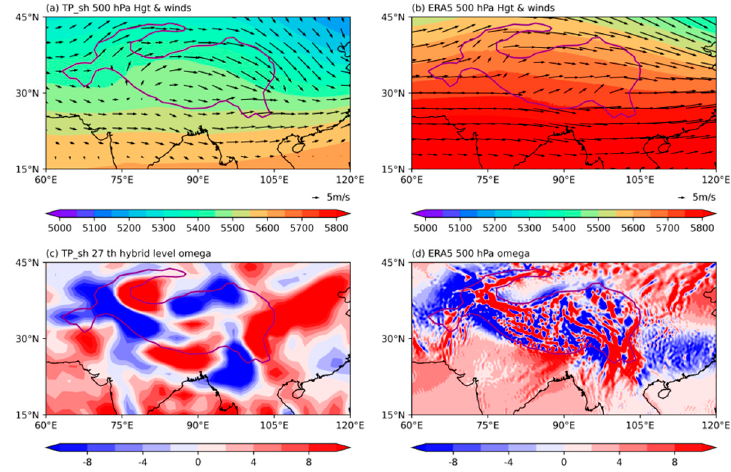
Figure 8. The simulated 500 hPa geopotential height (shaded, unit: gpm) and winds (vector, unit: m/s) in the TP_sh experiment ( a ), ( b ) as in ( a ), but with the climatology results derived from ERA5. The simulated vertical velocity (shaded, unit: 0.01 Pa/s) at the 27th hybrid level in the TP_sh experiment ( c ), ( d ) as in ( c ), but with the climatology result at 500 hPa derived from ERA5. The purple line is the 2000 m elevation contour.